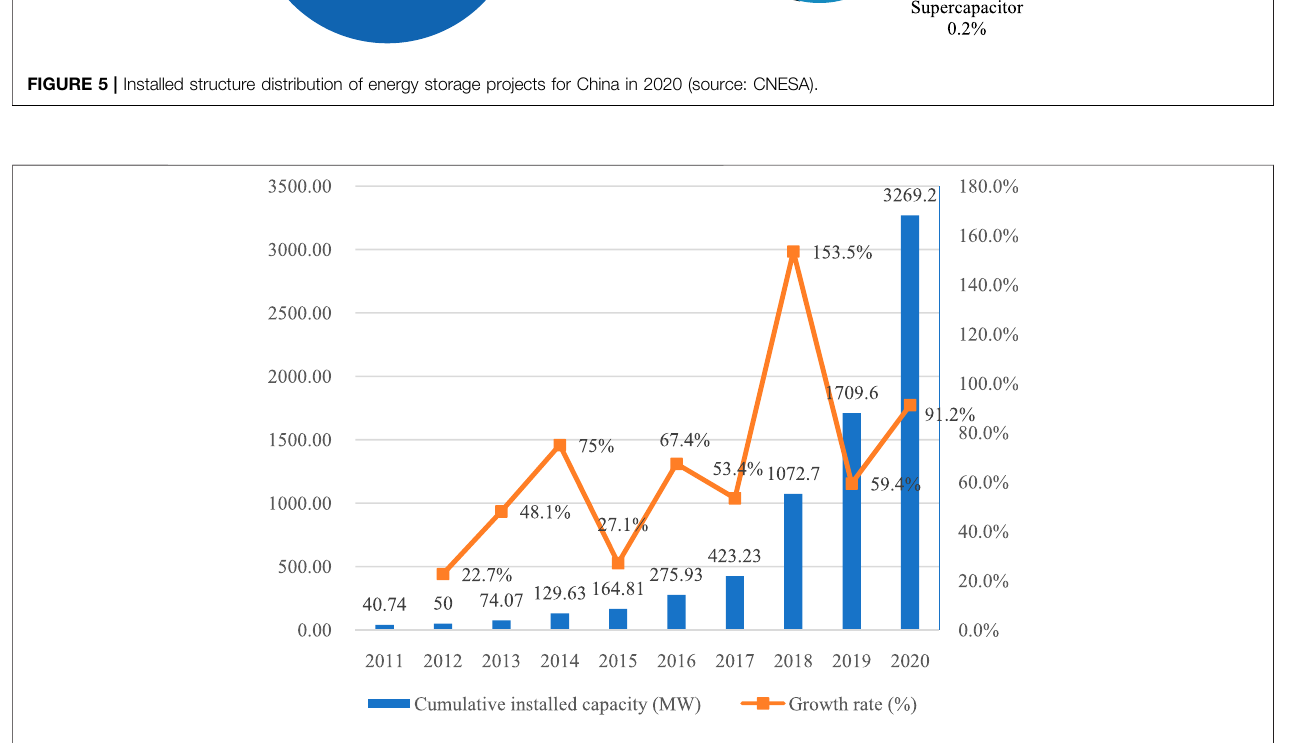
FIGURE 6 | Cumulative installed capacity of EES projects for China in 2011 –